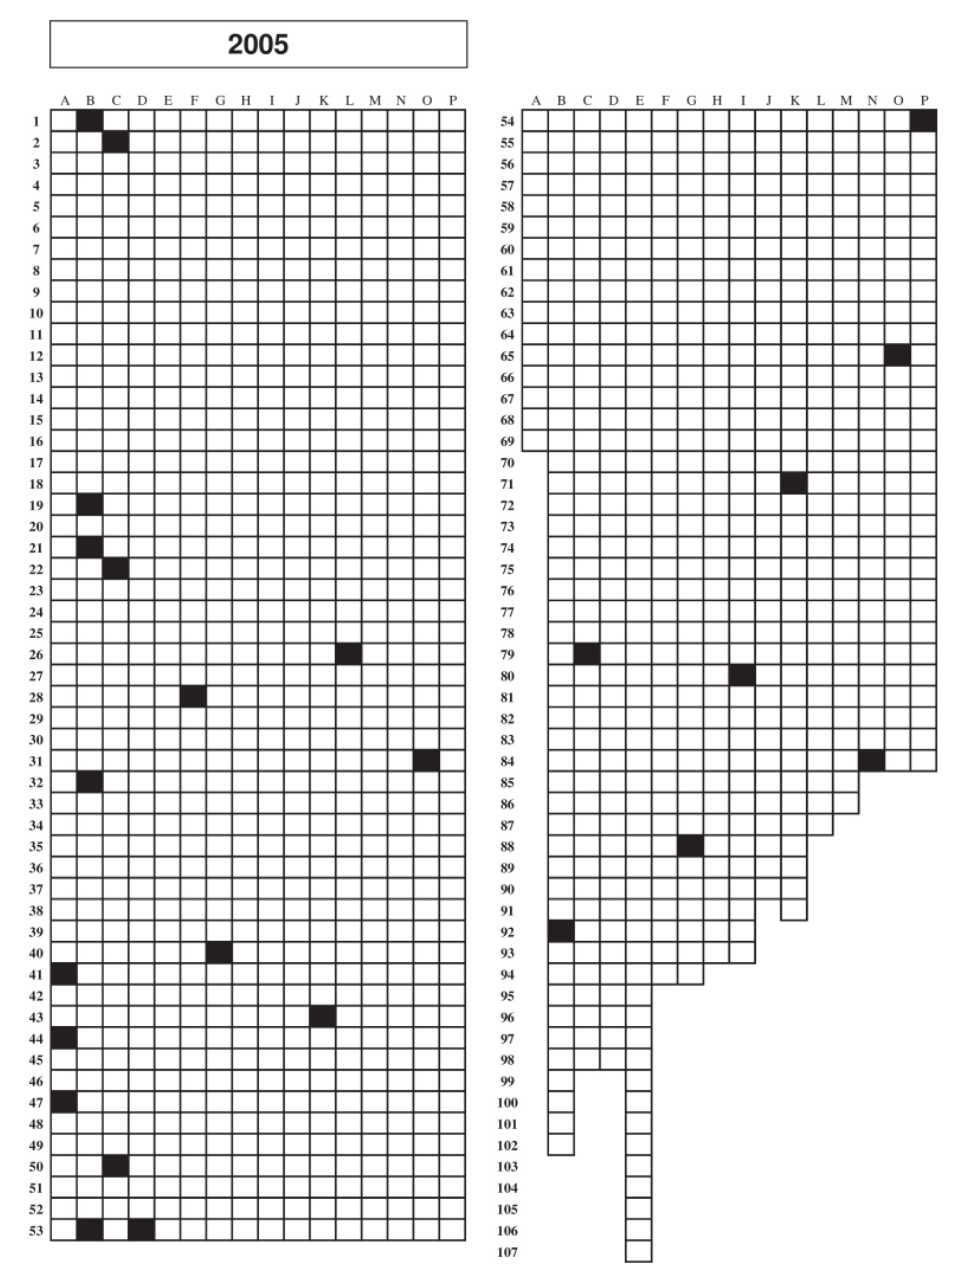
Fig. 6. Spatial pattern of esca-diseased plants in vineyard CAL-3 in the province of Prato in 2005. Black squares, symptomatic plants; open squares, asymptomatic